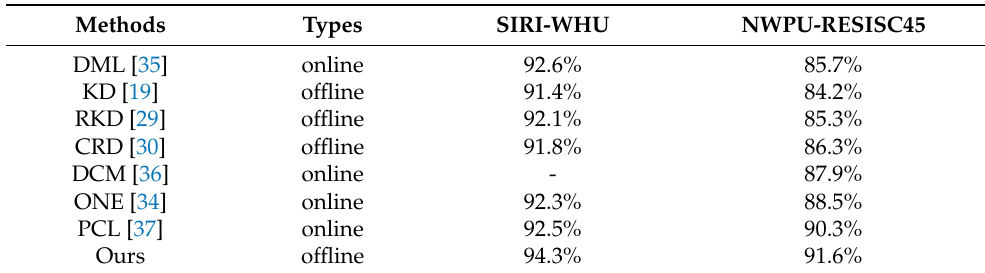
Table 3. The accuracy of ResNet110 while using different knowledge distillation approaches on SIRI-WHU and NWPU-RESISC45.